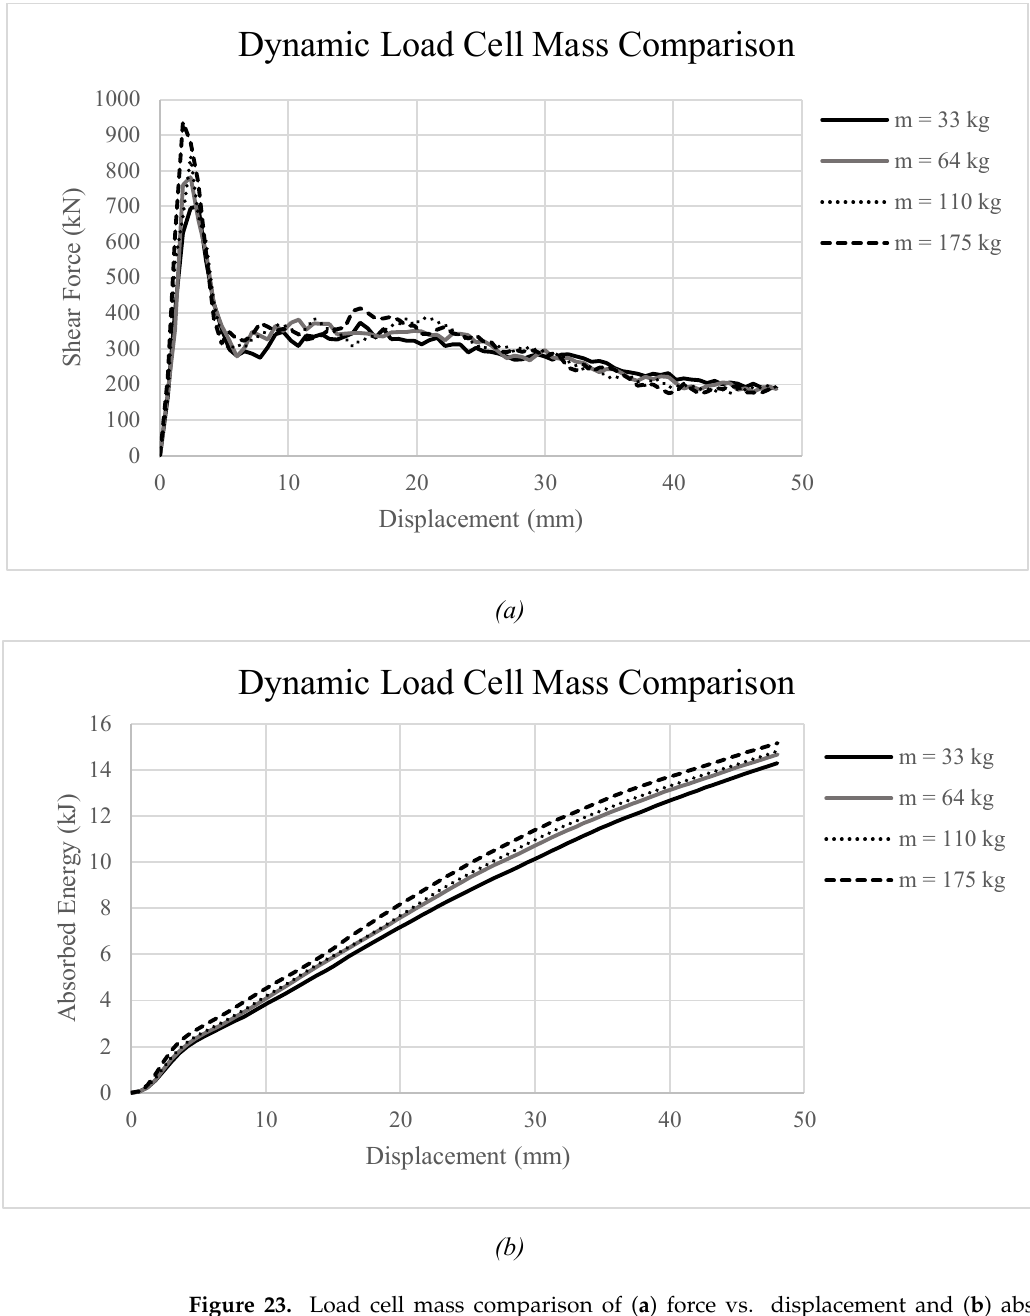
Figure 23. Load cell mass comparison of ( a ) force vs. displacement and ( b ) absorbed energy vs. displacement.